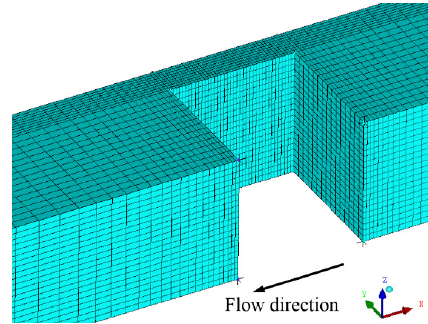
Figure 2. The micro-channel geometry in the simulation.